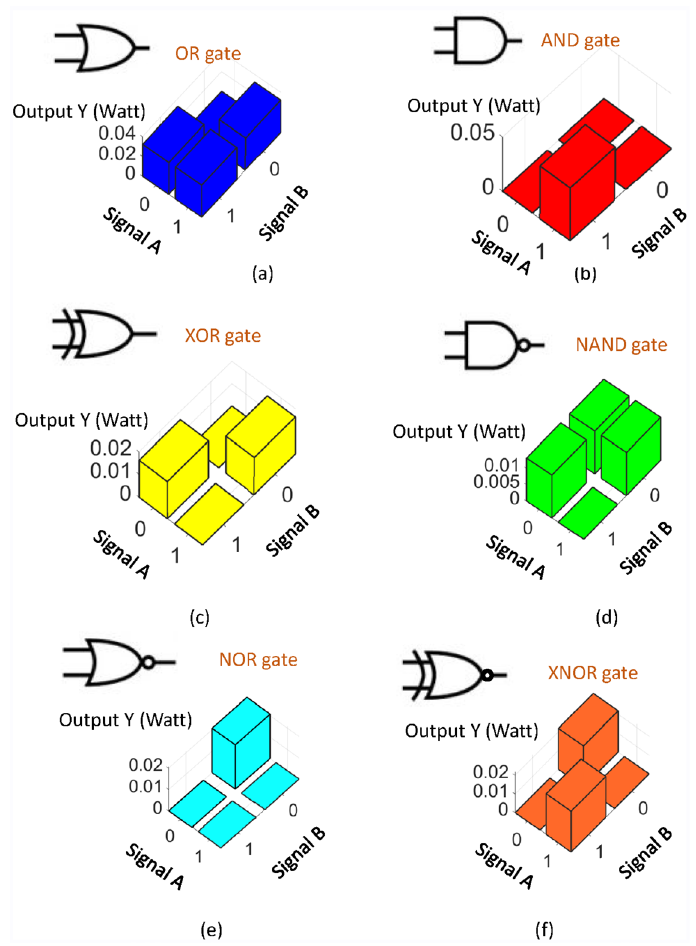
Figure 2. The output power of ( a ) OR, ( b ) AND, ( c ) XOR, ( d ) NAND, ( e ) NOR and ( f ) XNOR logic gates.